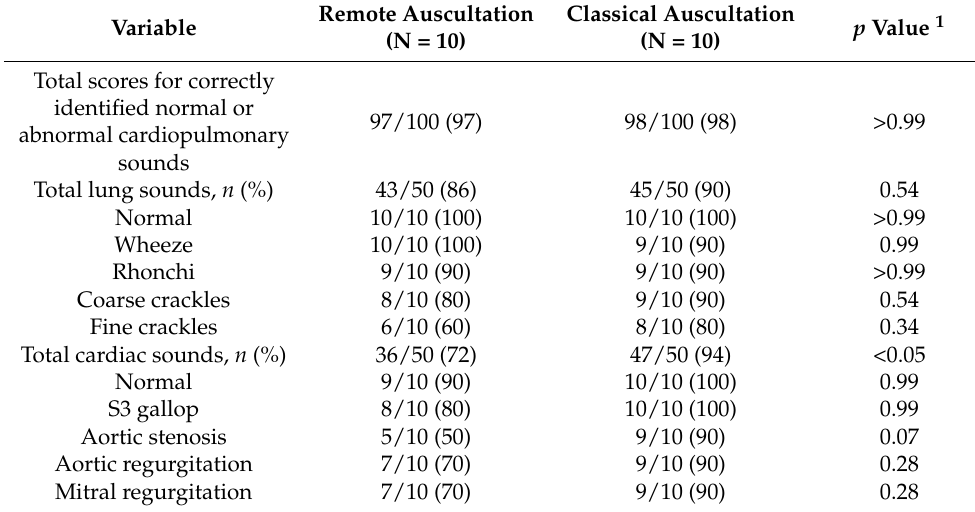
Table 2. Correct identification rates of sounds.